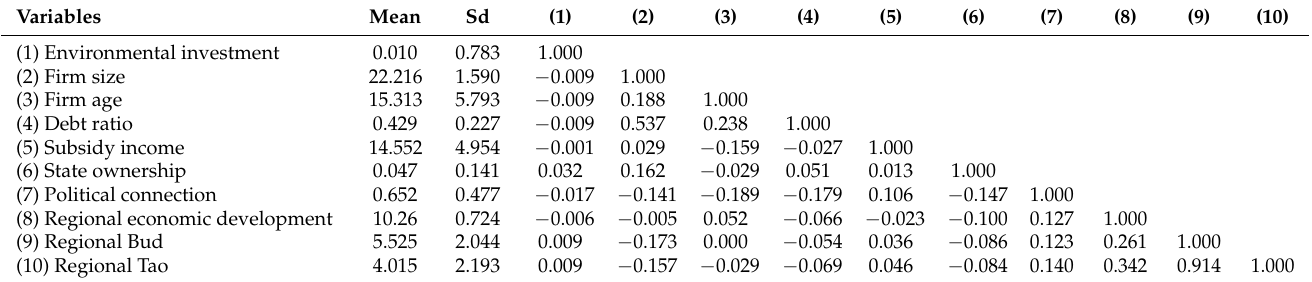
Table 2. Descriptive statistics and correlation for environmental investment dimension.